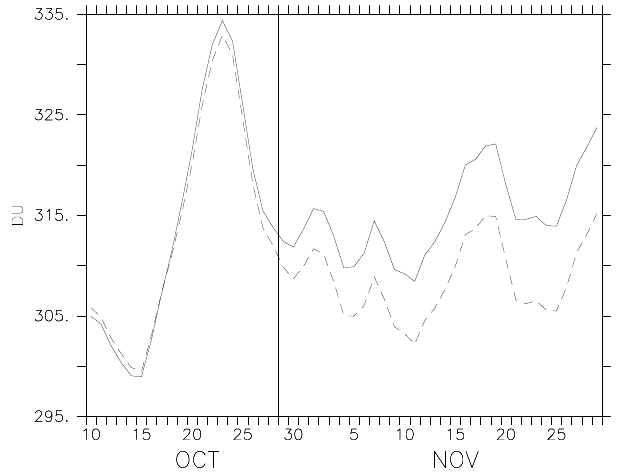
Fig. 13. Change of total ozone between the simulations S-SPE- NNOEFF (dashed line) and S-NOSPE (solid line) in the region 70– 90 ◦